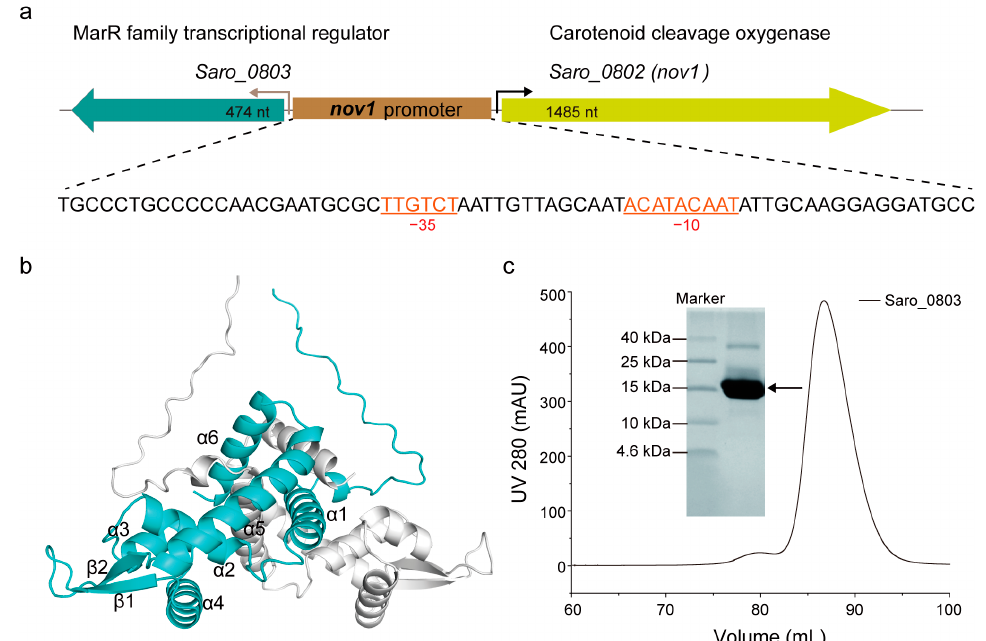
Figure 1. Biochemical and biophysical characterization of Saro_0803. ( a ) The gene organization of the resveratrol catabolic operon. The single oligonucleotide sequence of the nov1 promoter is displayed underneath, with canonical − 10 and − 35 boxes indicated (colored in orange). ( b ) The monomeric units in the structural model of Saro_0803 predicted by AlphaFold2 are colored in cyan and gray, respectively. ( c ) The expression and purification of transcriptional regulator Saro_0803 in vitro . Saro_0803 was purified by size exclusion chromatography using the HiLoad 16/600 Superdex 200 pg column and analyzed by tricine-SDS-polyacrylamide gel.